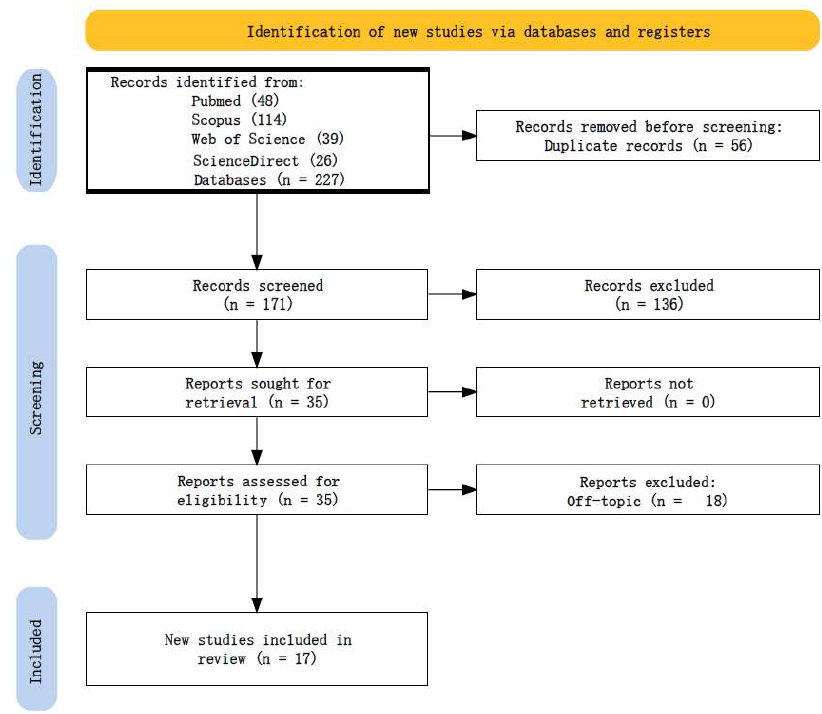
Figure 1. PRISMA flowchart diagram of the inclusion process.